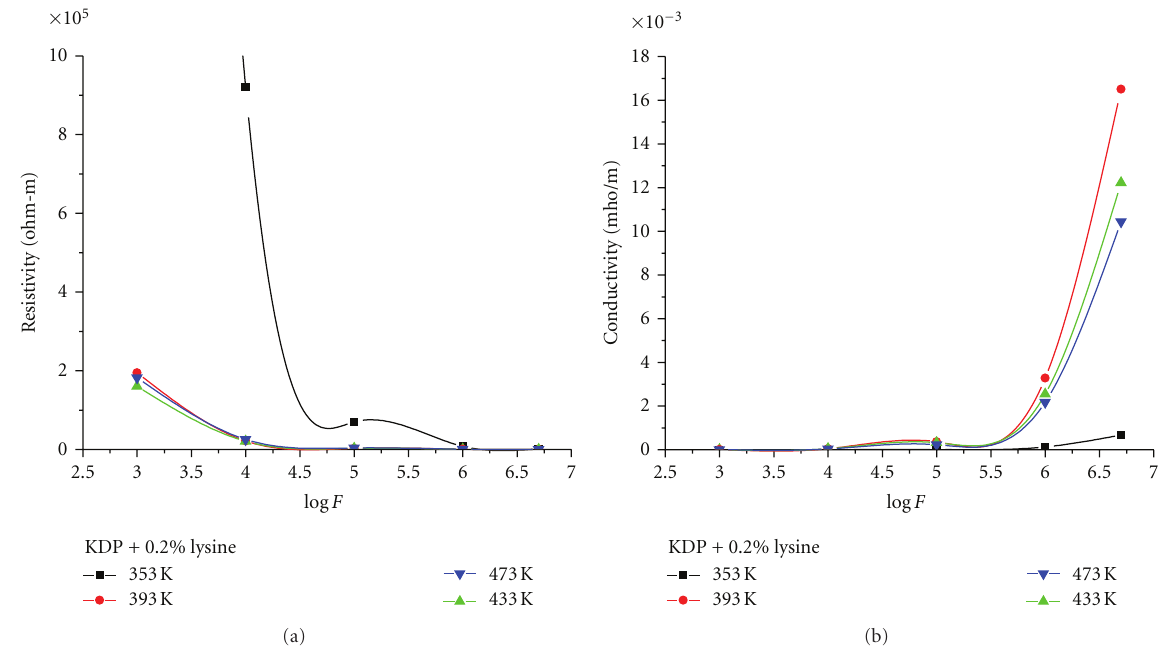
Figure 7: (a) Variation of resistivity with frequency (lysine-doped KDP). (b) Variation of conductivity with frequency (lysine-doped KDP).